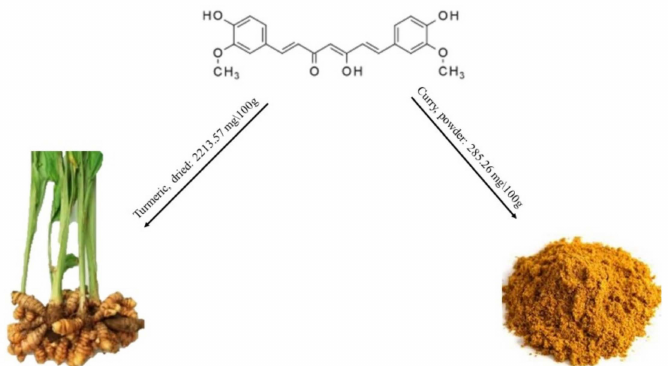
Figure 6. Structure of curcumin and its content in main foods, according to the database Phenol-Explore.